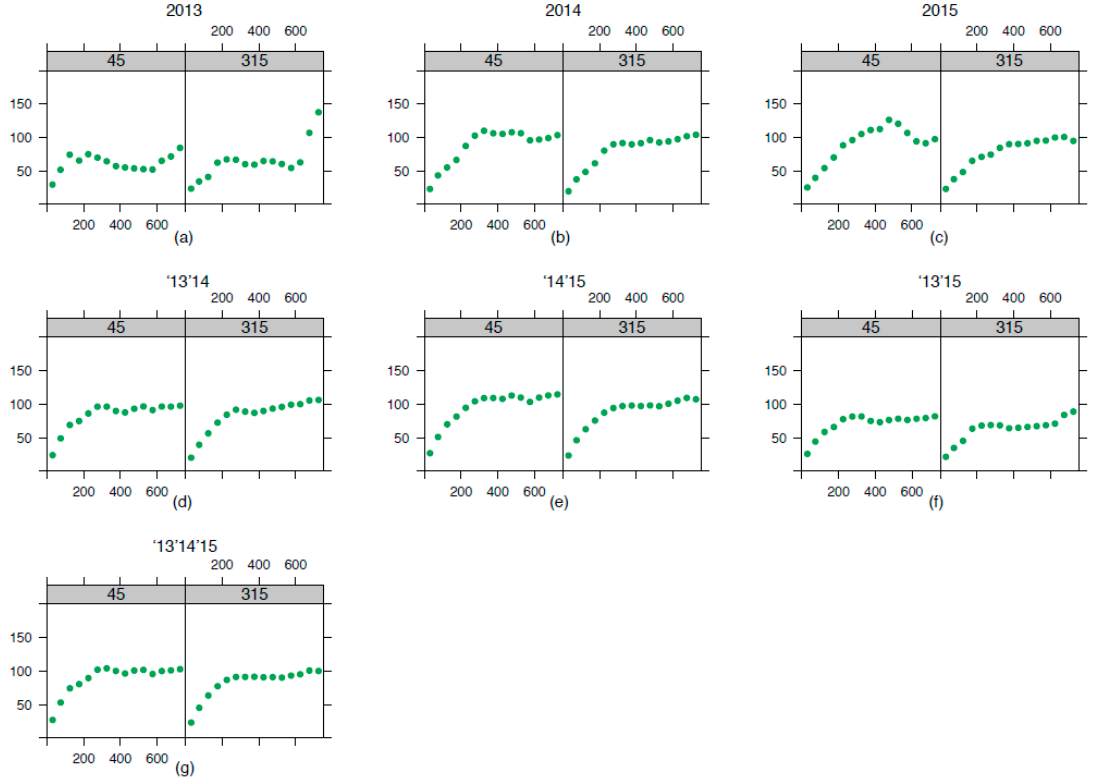
Figure 13. The 45° and 315° variograms at short distances for the first PC values ( a – g ) for all single (2013, 2014, and 2015) and multi-temporal composites (‘13’14, ‘14’15, ‘13’15, and ‘13’14’15). On the x-axis the distance [m] and on the y-axis the semi-variance.